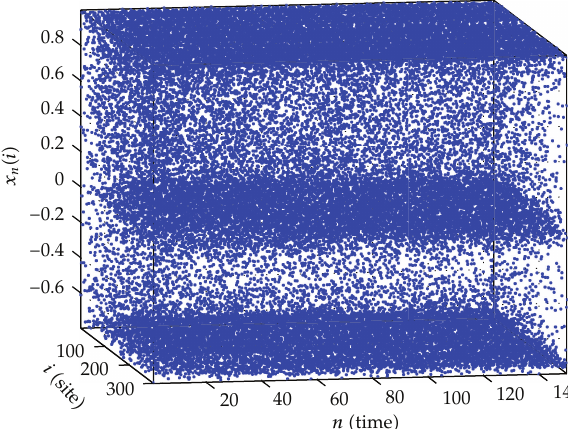
Figure 1: Spatiotemporal chaos in the DCML (cid:3) 3.18 (cid:4) without any control, with parameters N (cid:8) 300, a (cid:8) 1 . 8, (cid:2) (cid:8) 0 . 01.